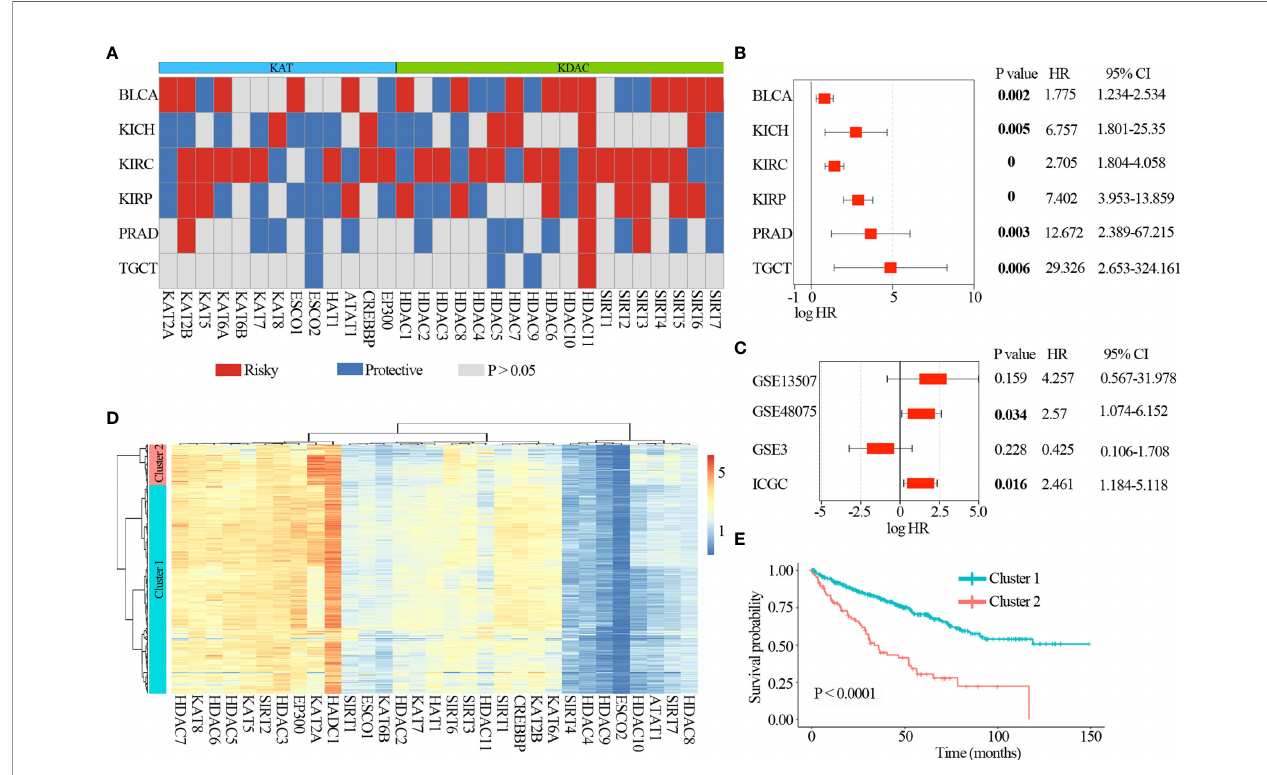
FIGURE 5 | Clinical relevance of lysine acetylation regulators across 6 cancer types. (A) Summary of the correlation between expression of lysine acetylation regulators and patient survival. Red represents a higher expression of lysine acetylation regulator associated with worse survival, and blue represents an association with better survival. Only p values < 0.05 are shown. (B) The distribution of hazard ratios across 6 cancer types. (C) The distribution of hazard ratios across different GEO datasets. (D) Heat map showing the clustering for kidney renal clear cell carcinoma patients based on the expression of lysine acetylation regulators. (E) Kaplan-Meier survival plot of patients grouped by global expression pattern of lysine acetylation